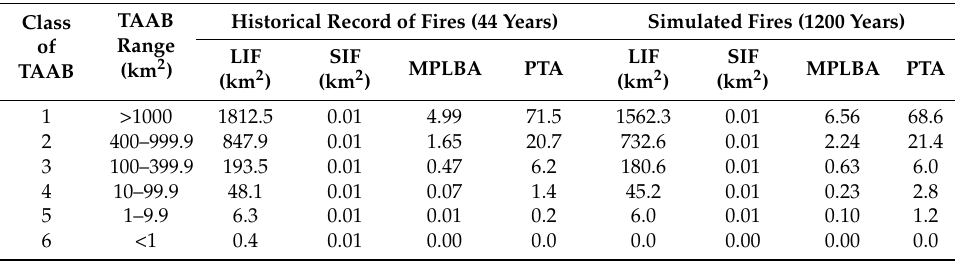
Figure 1. The 44-year historical record of total annual area burned, rank-ordered from most- to least-area burned in a year. Classes of total annual area burned: Class 6: <1 km 2 ; Class 5: 1–9.9 km 2 ; Class 4: 10–99.9 km 2 ; Class 3: 100–399.9 km 2 ; Class 2: 400–999.9 km 2 ; Class 1: ≥ 1000 km 2. Table 1. Fire characteristics in six classes of total annual area burned (TAAB) for 44 years of historical records from Wood Buffalo National Park and 1200 years of simulated